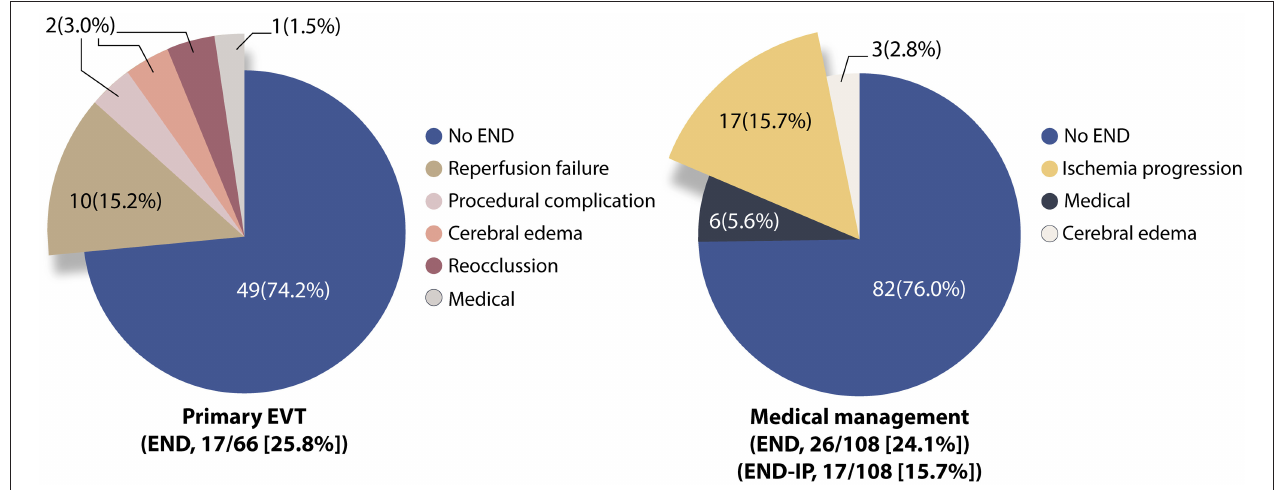
FIGURE 1 | The distribution of causes of early neurological deterioration in the primary endovascular treatment group and medical management group. END, early neurological deterioration; EVT, endovascular treatment; END-IP, early neurological deterioration-ischemia progression.